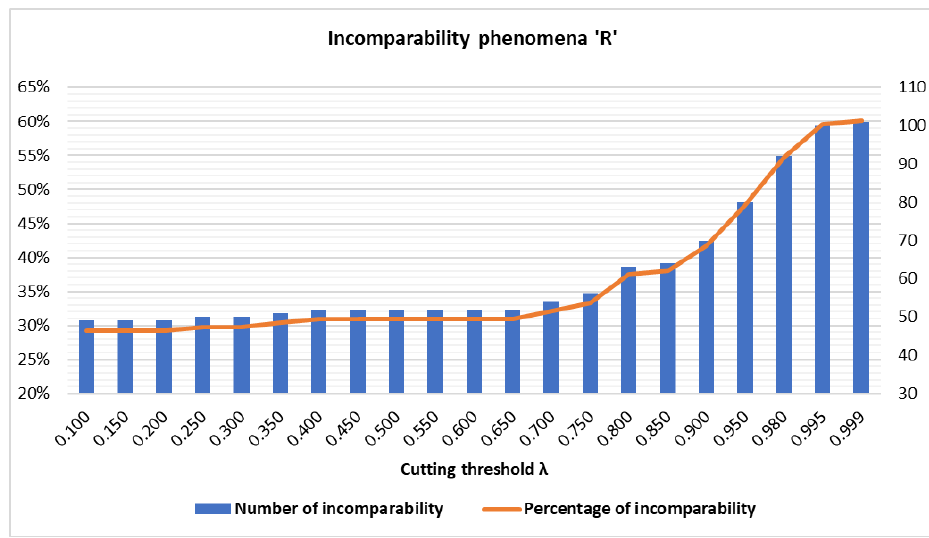
Figure 11. Occurrence of the incomparability phenomenon as a function of λ .